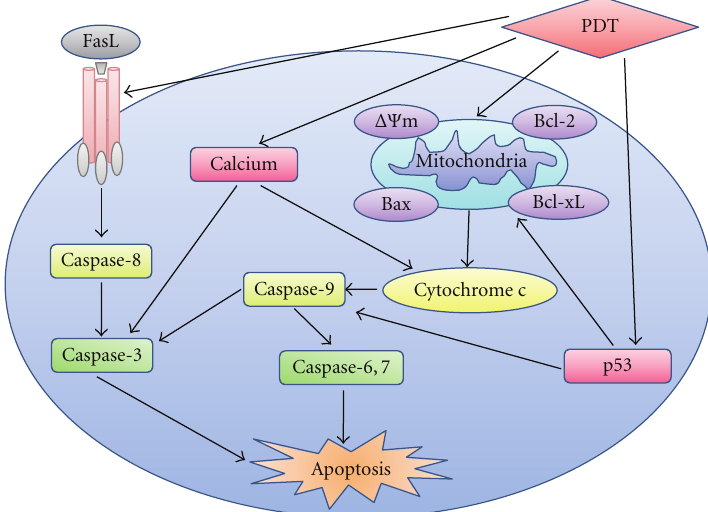
Figure 3: Schematic illustration represents the possible e ff ect of PDT on the apoptosis pathways. PDT-associated apoptotic progress is a complicated occurrence which activates the mitochondrial pathway, promotes cytochrome c releases and caspase-3, -6, -7 activation. Moreover, PDT also influences cancer cellular apoptosis via the elevation levels of p53 and intracellular calcium.